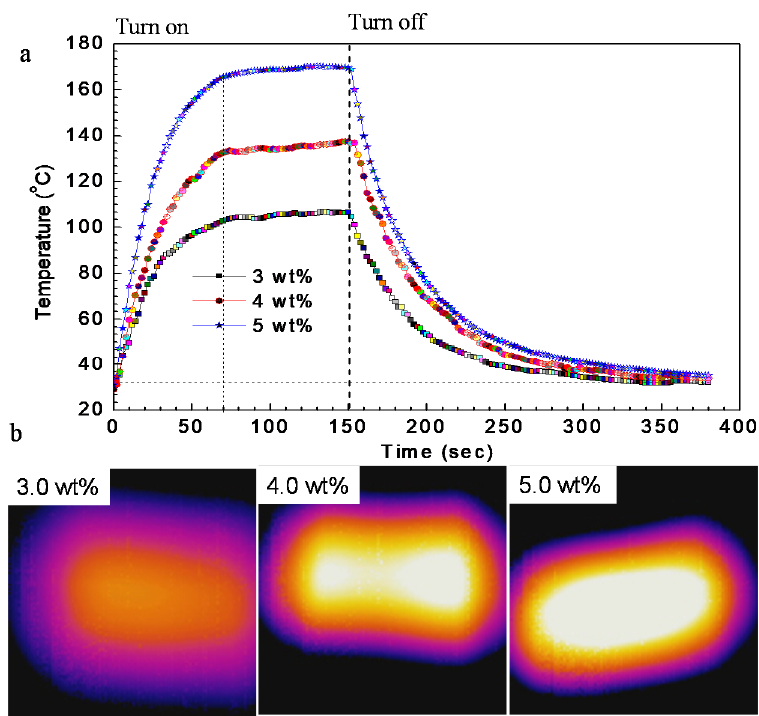
Figure 7. ( a ) Time-dependent temperature of the composite films with different mass contents of graphene under the operation for input voltage 15 V, ( b ) IR images of the composite films at steady state temperature.